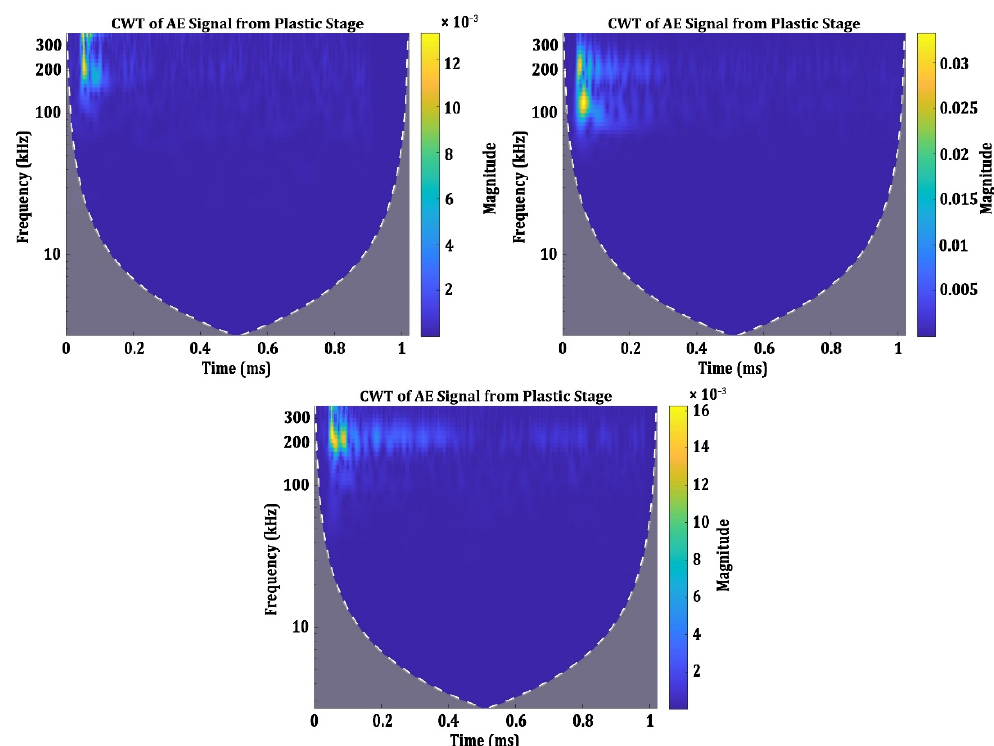
Figure 7. CWT Spectrograms of the AE signals from the plastic stage.